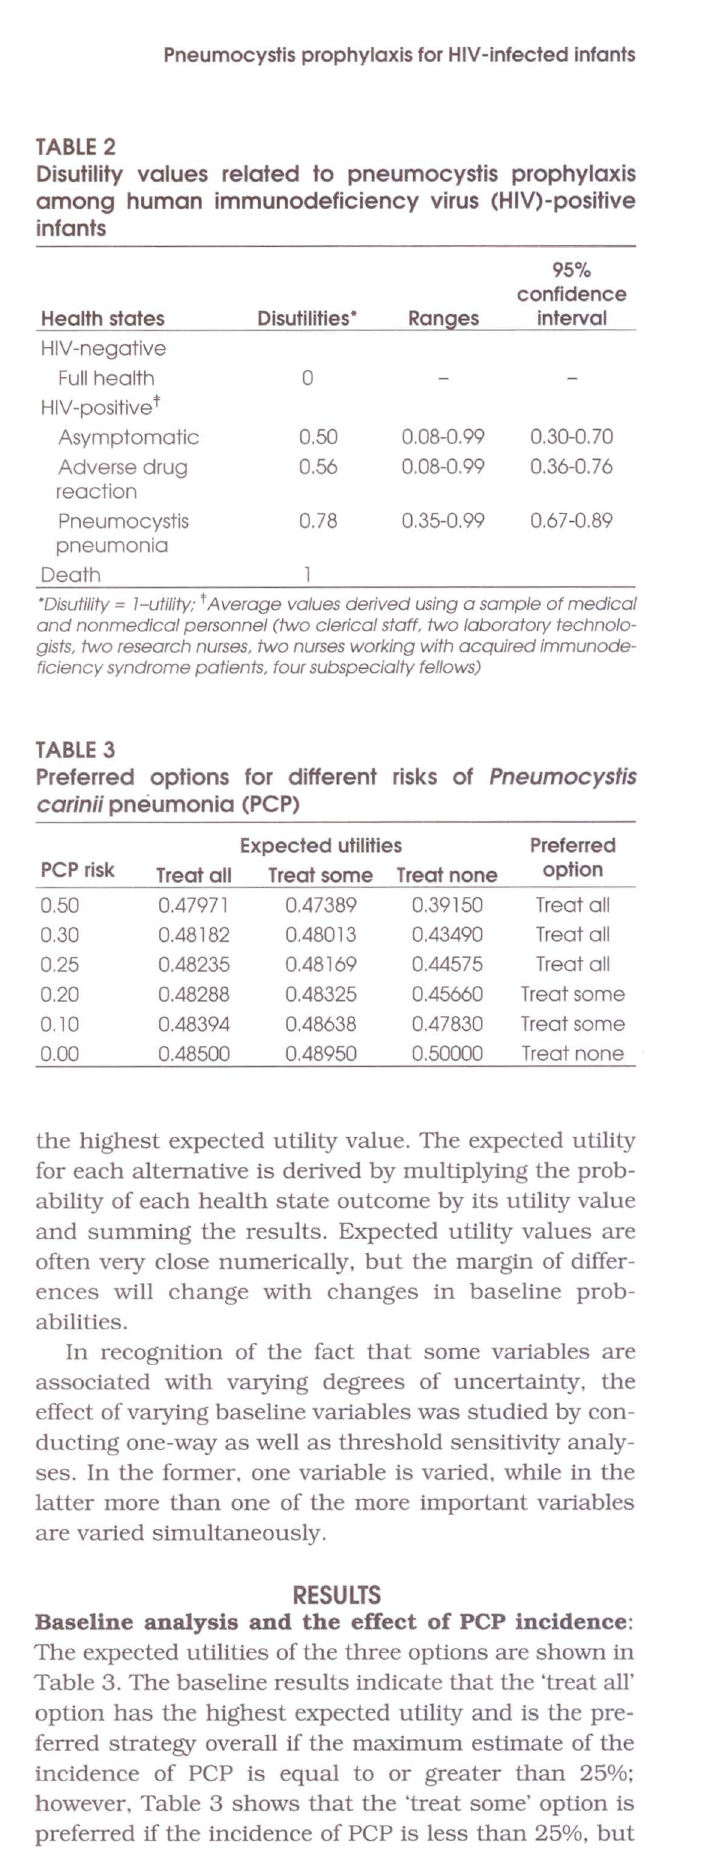
Disutility values related to pneumocystis prophylaxis among human immunodeficiency virus (HIV)-positive